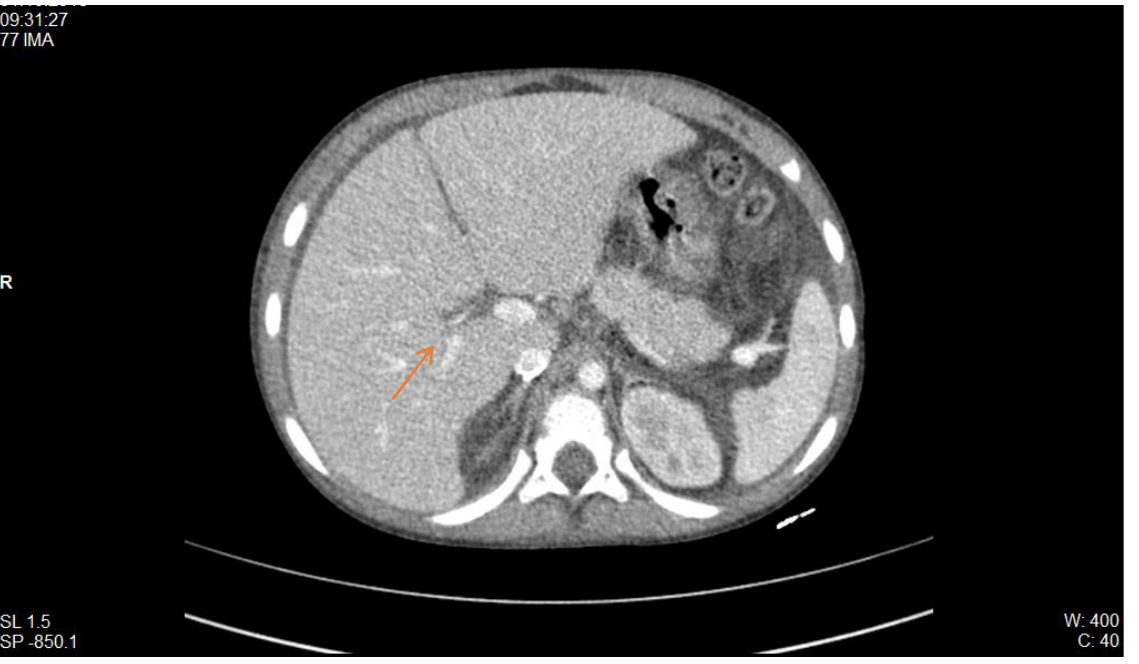
Figure 2. CT scan: thrombosis of the inferior vena cava with extension to the right renal vein (red arrow) (personal collection Nephrology Department).